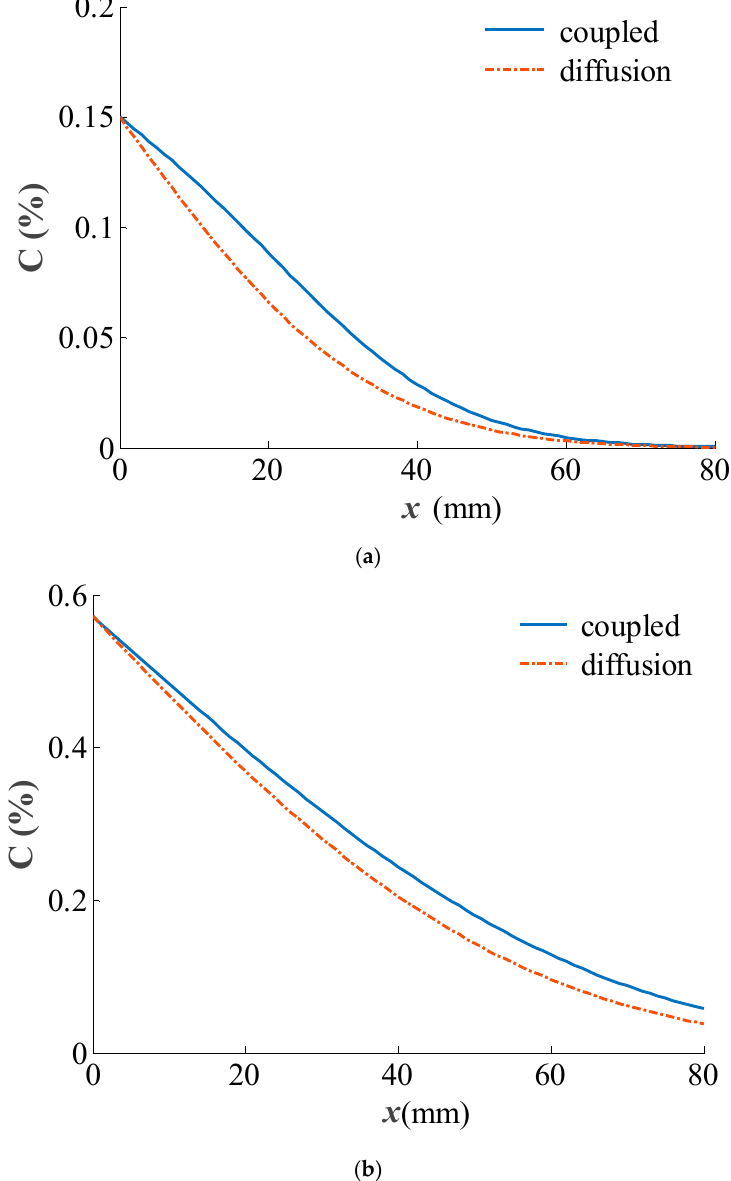
Figure 7. The concentration distribution of the chloride ion under the coupled effect or diffusion only in the ( a ) inside and ( b ) outside of the lining.